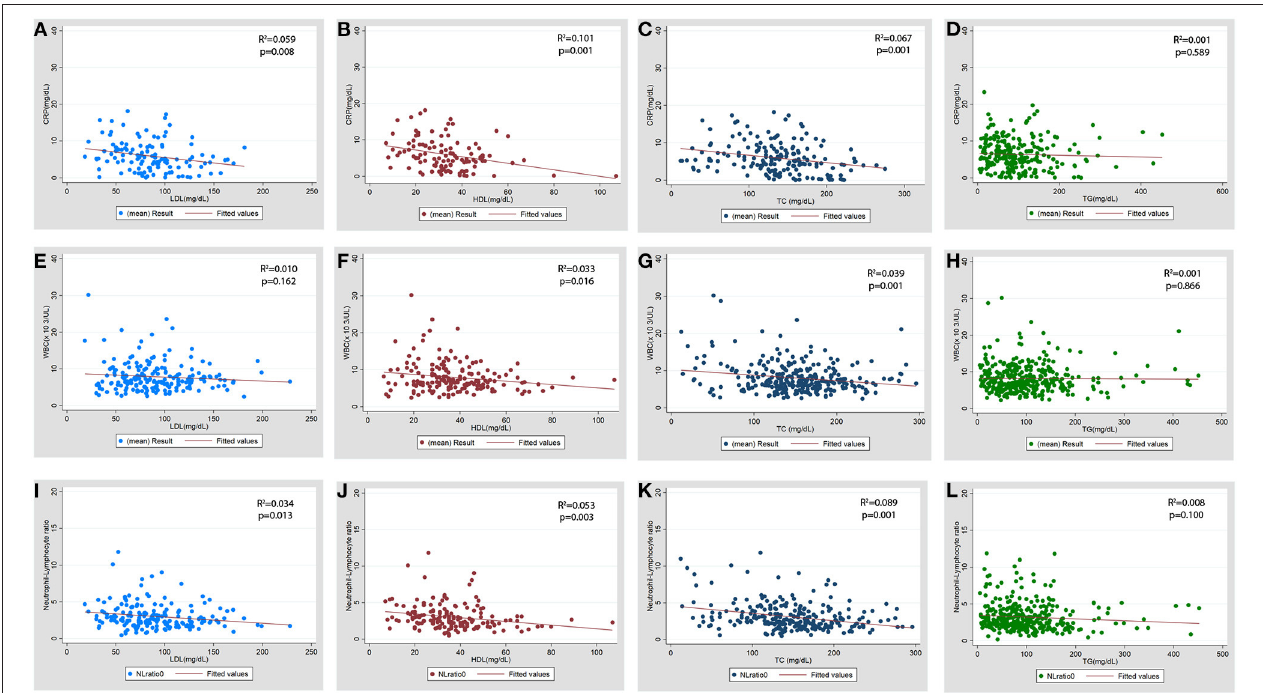
FIGURE 4 | Scatter plot for the association of baseline serum lipid levels with baseline inflammatory markers. (A–D) CRP (C-reactive protein), (E–H) WBC (total leukocyte count x10 3 / µ L), (I-L) NL ratio (neutrophil lymphocyte ratio). LDL, low density lipoprotein; HDL, high density lipoprotein; TC, total cholesterol; TG,